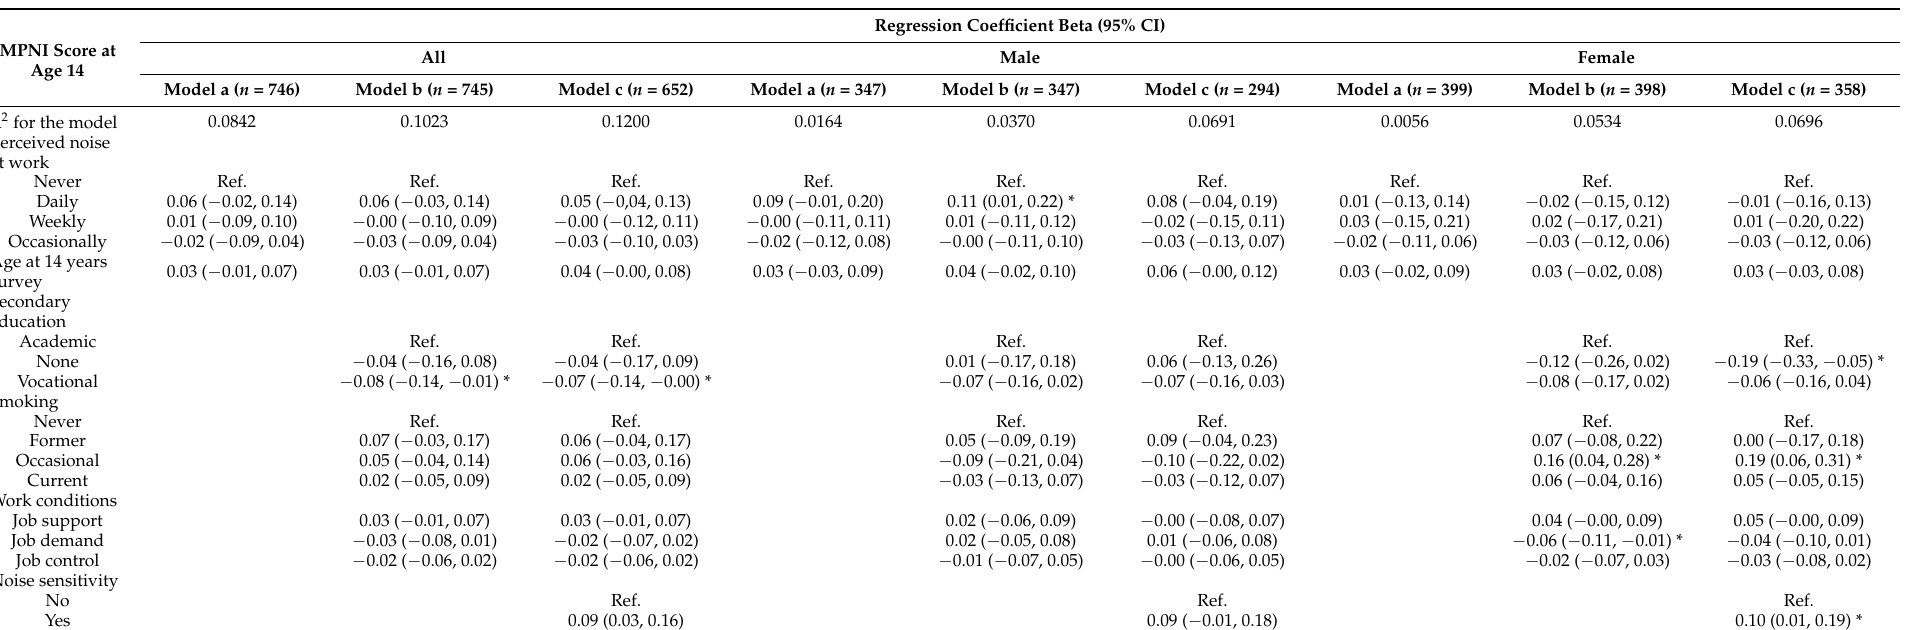
Table A1. Linear multivariable regression models of the association of depressive symptoms at age 14 using the MPNI scale with perceived occupational noise exposure and selected covariates in young